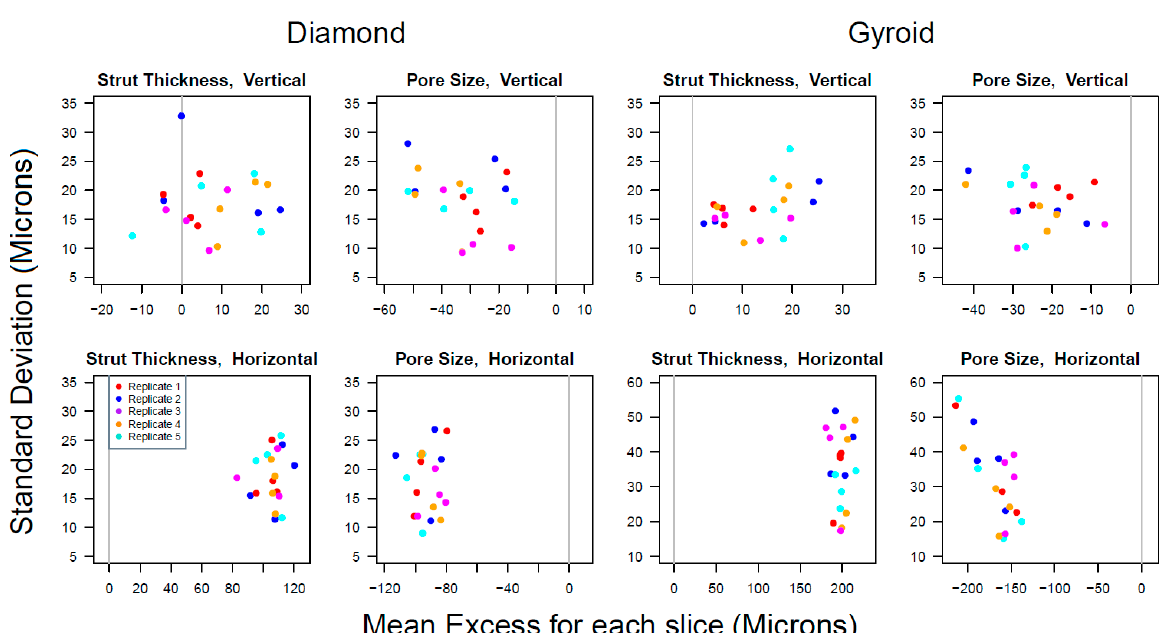
Figure 6. Within-slice standard deviations were plotted against the mean excess (i.e., the slice mean minus target value) for each structure type, variable and strut orientation. Different colours denote the 5 different replicates of each printed structure. The x -axis scales differ in each panel. The y -axis scales are the same in all panels, except for the horizontal strut measurements for gyroids, where they cover a wider range. The grey vertical line at zero marks where the mean measurement would equal the target value. Replicates 1, 2, 3, 4, 5 are shown by red, blue, purple, orange and turquoise colours, respectively.